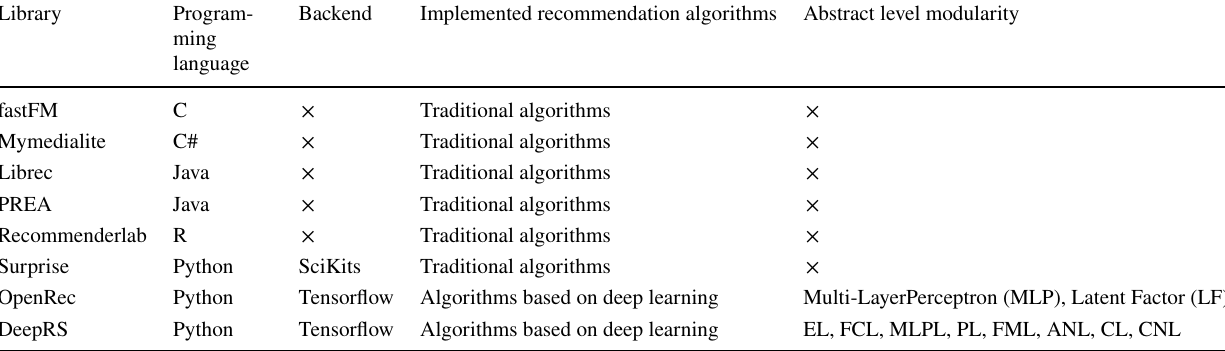
Table 3 Comparing DeepRS to existing library for recommender systems